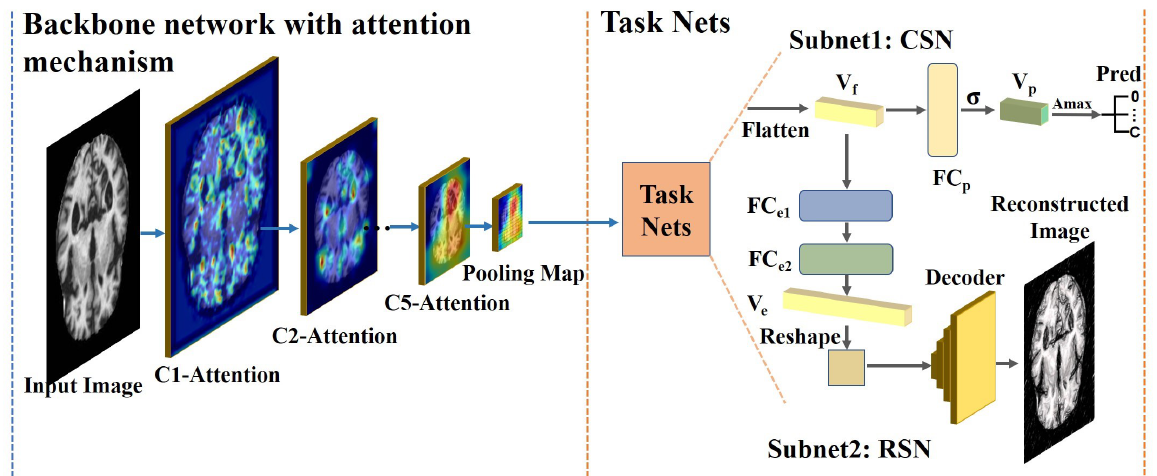
Figure 1. The proposed framework. The framework consists of two parts, including a backbone network with an attention mechanism that acts as a shared network for extracting salient features and task nets that contain two sub-networks. The two sub-networks simultaneously conduct two sub-tasks, i.e., classification and